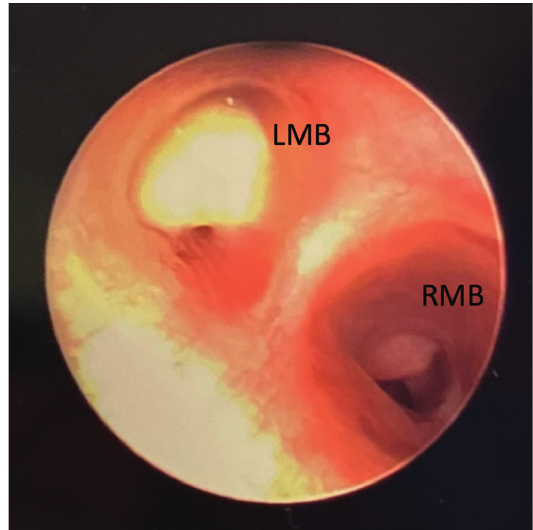
Figure 4: Images taken from diagnostic bronchoscopy, displaying a peanut causing near-complete occlusion of the left mainstem bronchus (LMB) and granulation tissue in the right mainstem bronchus (RMB). The RMB granulation tissue suggesting the peanut had recently moved, potentially after coughing, leading to the acute deterioration. The peanut was subsequently removed and the patient improved